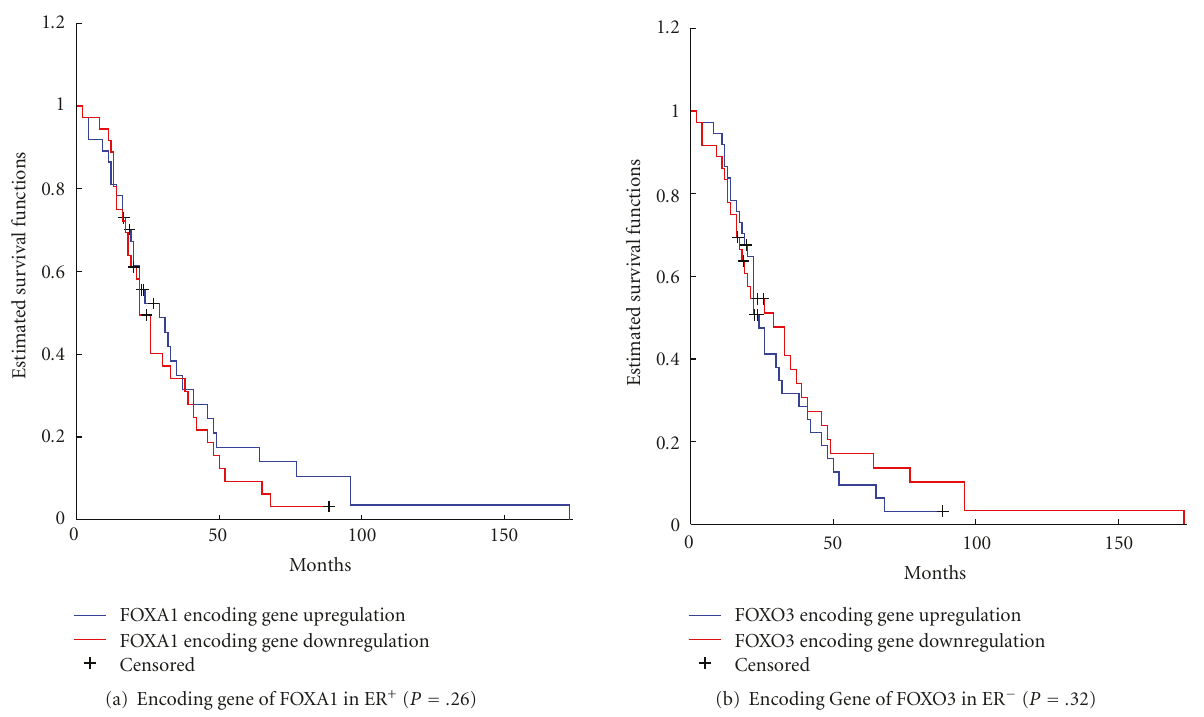
Figure 15: Kaplan-meier survival estimates for the encoding gene of FOXA1 in ER + and the encoding gene of FOXO3 in ER − .